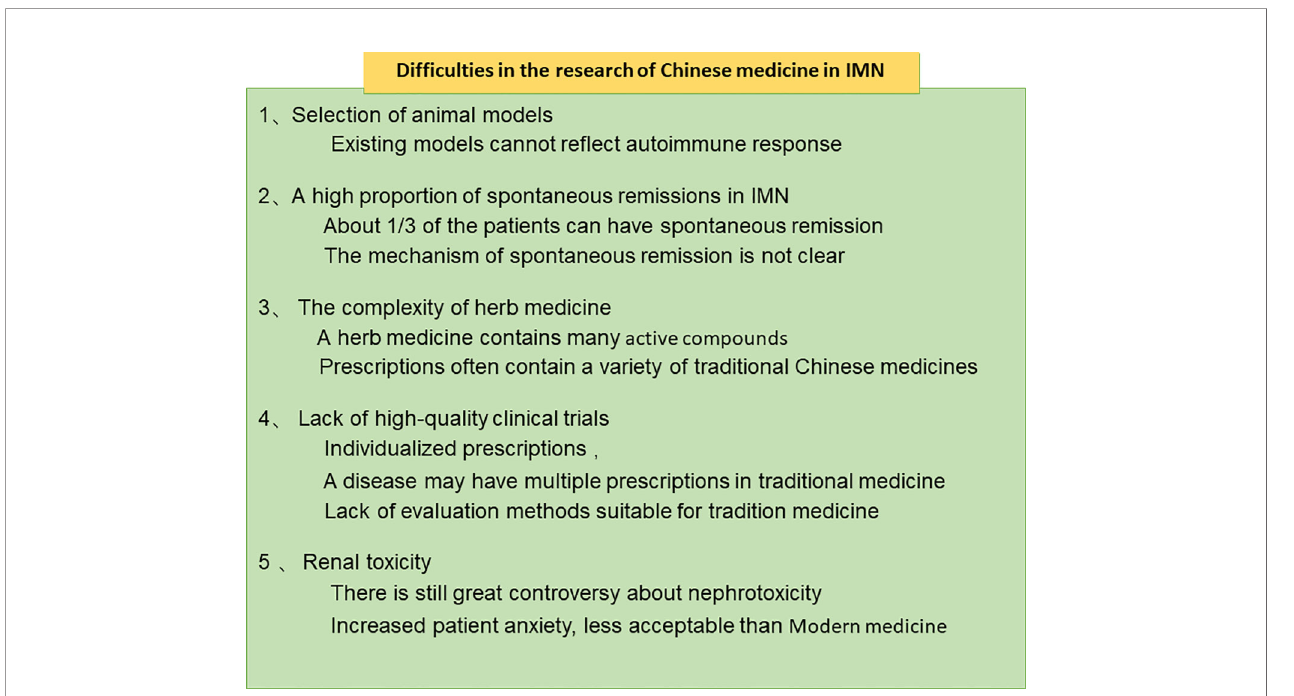
FIGURE 3 | Dif fi culties in the research of Chinese medicine in